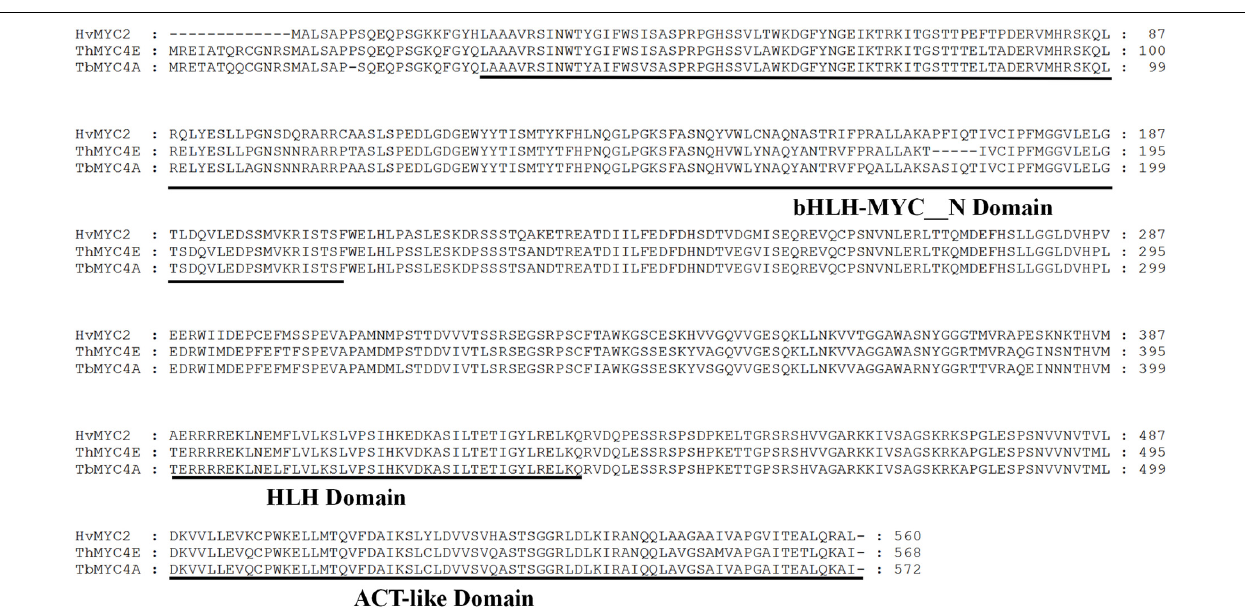
FIGURE 3 | Comparison of the amino acid sequence of TbMYC4A with those of ThNYC4E , HvMYC2 , and bHLH transcription factors known to regulate anthocyanin biosynthesis from Thinopyrum ponticum and Hordeum vulgare , with black lines representing bHLH-MYC_N, HLH and ACT-like domains. The accession numbers of these proteins (or translated product) in the GenBank database are as follows: Thinopyrum ponticum /MYC4E:KX914905.1 and Hordeum vulgare /MYC2:MF679157.1.